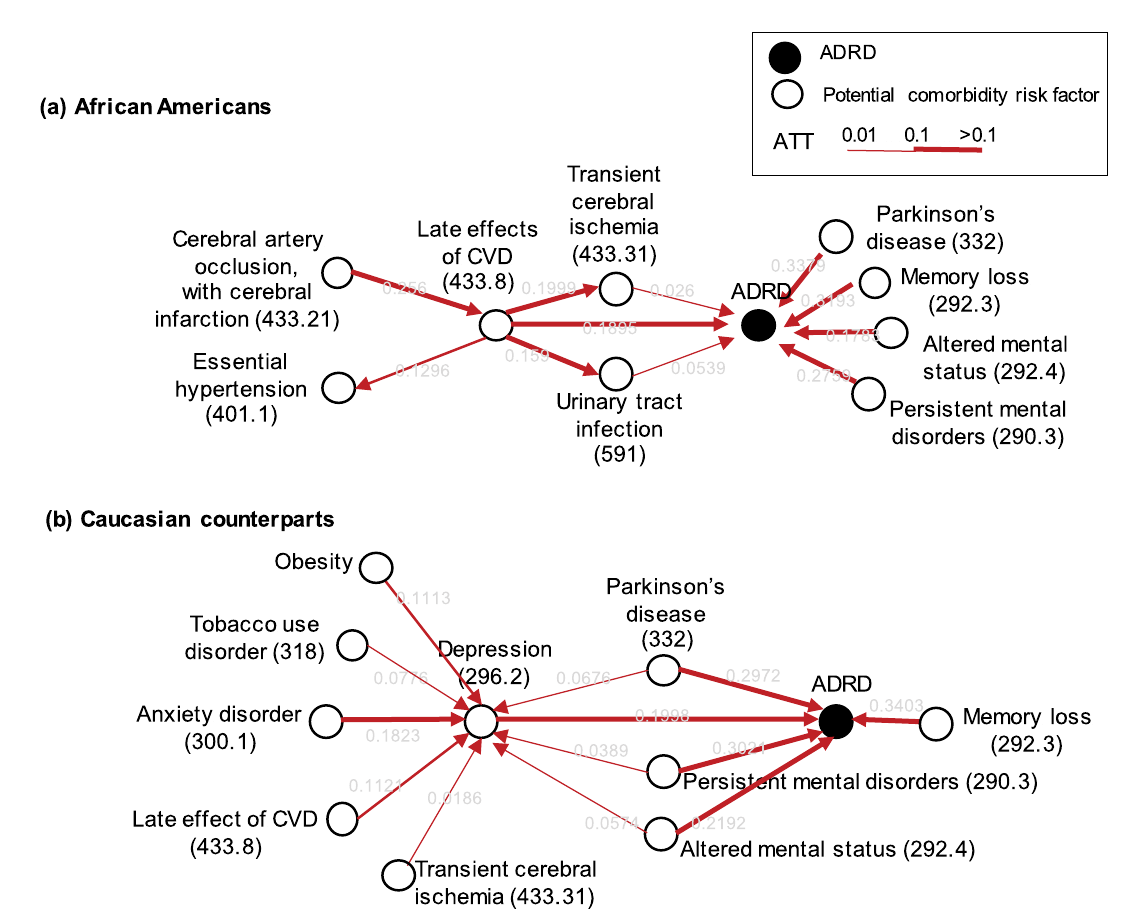
Fig 3. Bayesian Networks developed from the Cerner EHR Dataset that illustrates the differential risks for ADRD in African Americans (a) and Caucasians (b). We highlighted the major identified variables that contribute to the risk for developing the late effects of CVD and how CVD contributes to the risk for ADRD in older African Americans (a). Cerebral artery occlusion and cerebral infarction lead to late effects of CVD, and the late effect of CVD leads to transient cerebral ischemia or ADRD directly (a). The full Bayesian network is in S2 Table.